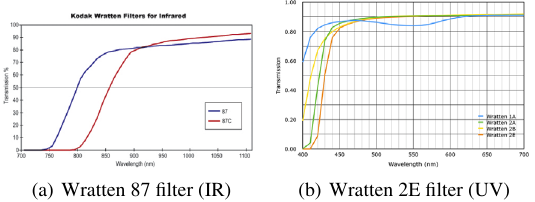
Figure 7: Specifications of gel filters used for IR and